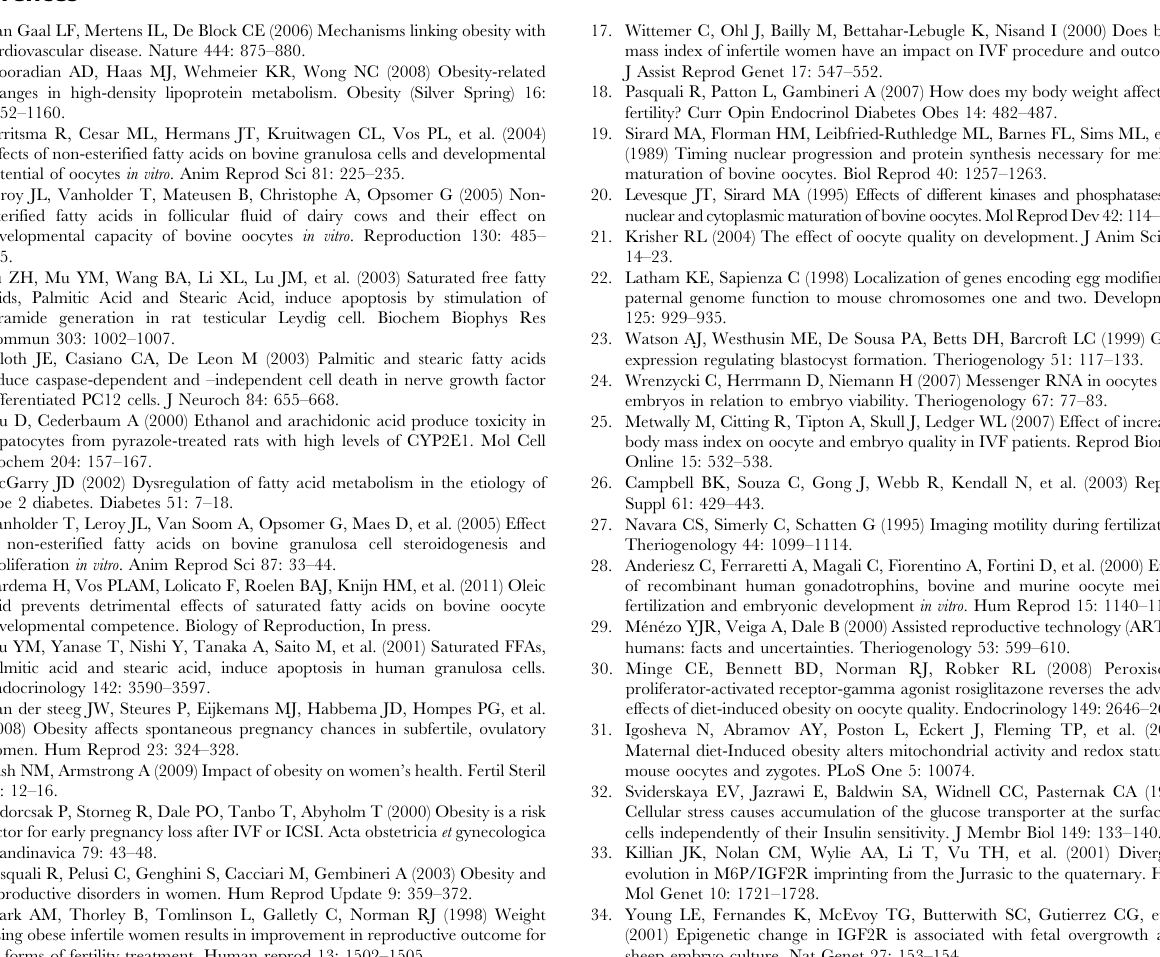
Table S1 Details of primers used for